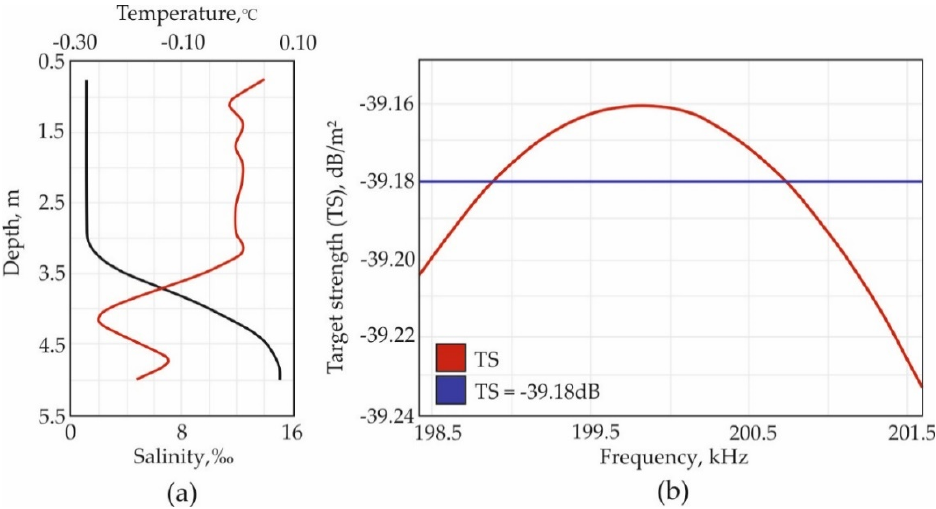
Figure 3. Simrad EK15 calibration: temperature and salinity profiles ( a ); observed (red line) and averaged (blue line) frequency dependence of target strength ( TS ) ( b